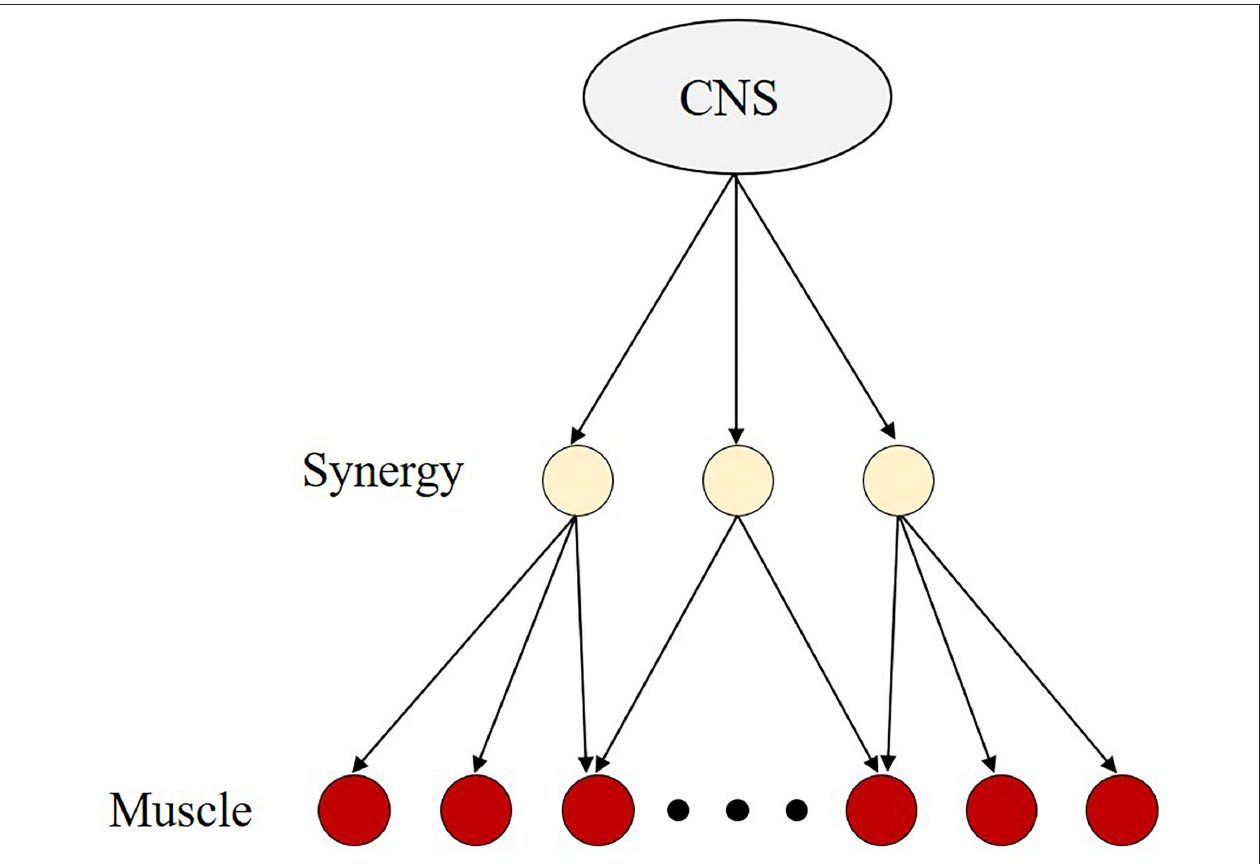
FIGURE 2 | The concept of the muscle synergy hypothesis. Because the human body has a greater number of degrees of freedom to successfully perform the motor task, it is believed that the central nervus system (CNS) is always faced with the problem of choosing a certain combination from an infinite number of possibilities. It implies that the CNS needs to perform a large amount of computation. To address this problem, CNS is believed to adopt a control strategy that reduces the number of degrees of freedom requiring control, i.e., the muscle synergy hypothesis. The muscle synergy hypothesis is based on the assumption that the CNS controls synergies composed of multiple muscles, rather than individual muscles separately. With this control strategy, the CNS may be less computationally demanding than when controlling individual